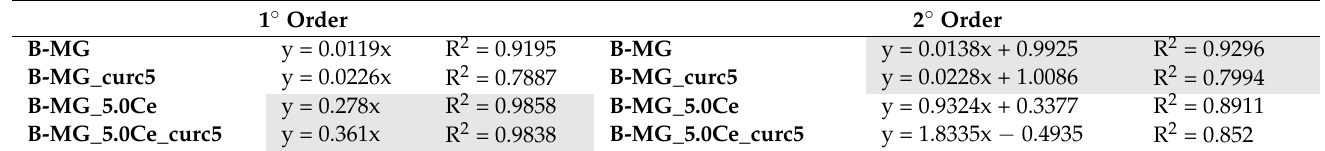
Table 4. Linear equations and kinetic order of degradation in each sample.